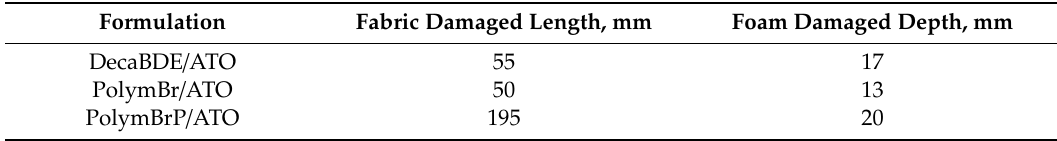
Table 2. Damaged lengths and depths of PU foams after flame extinction at the “pass” condition [45].